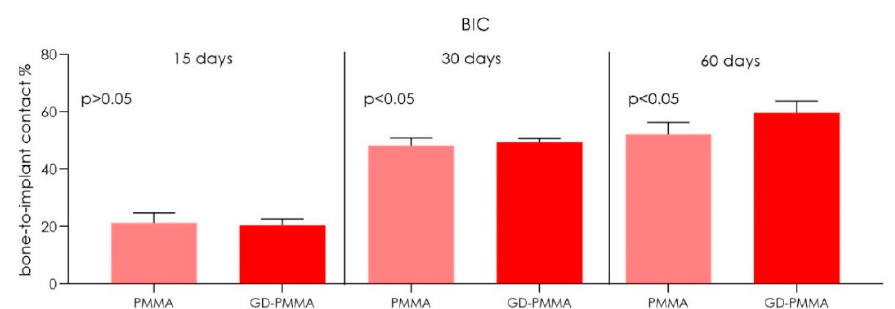
Figure 6. Chart of histomorphometric bone-to-implant contact percentage (BIC%) between the PMMA implants group and GD-PMMA implants group. A significant difference was detected between PMMA and GD-PMMA groups at 30 days and 60 days (Kruskal Wallis followed by the Bunn’s test).